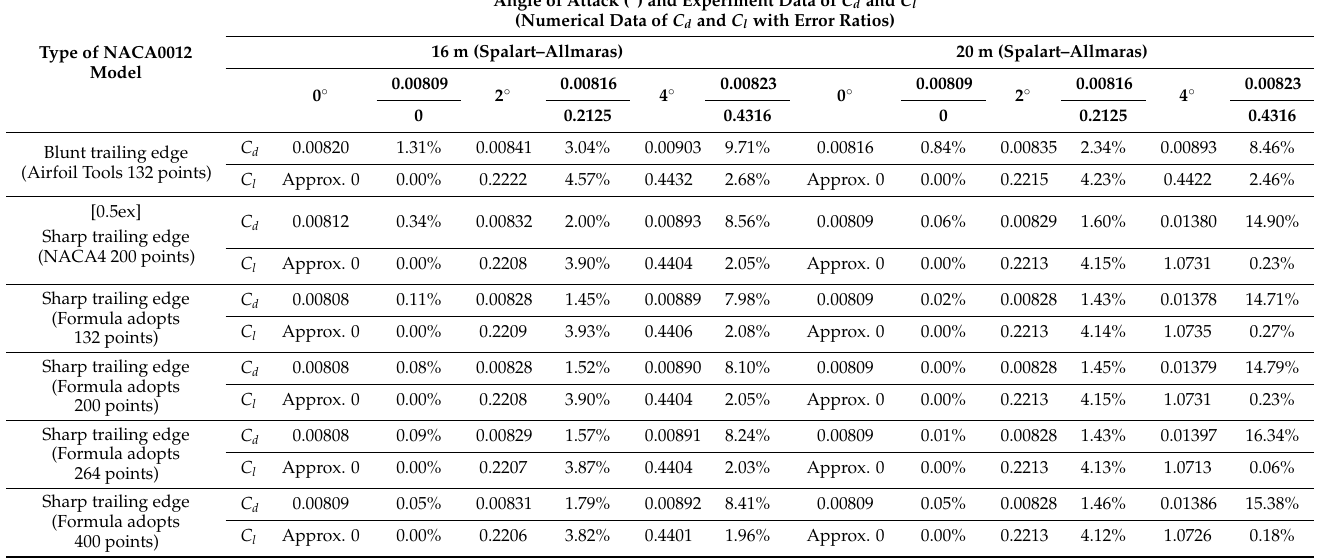
Table 7. Simulation results of C d and C l with error ratios adopting Spalart–Allmaras and far-field distances of 16 m and 20 m.